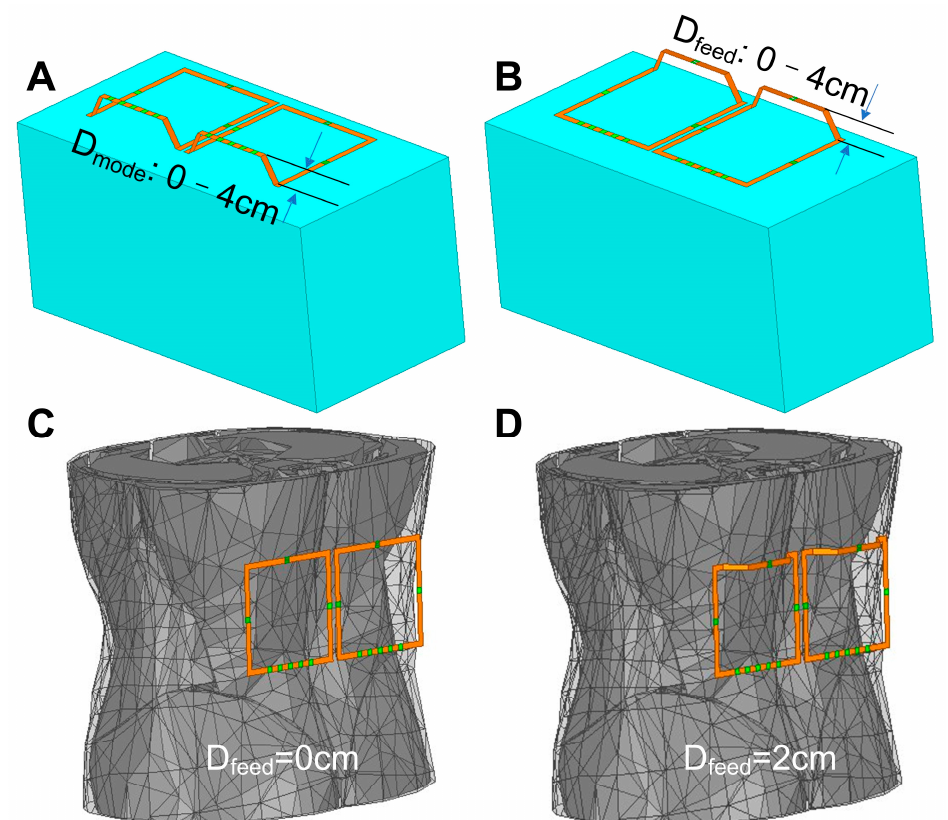
Figure 2. EM simulation models for optimizing lift-off distances of the mode conductor D mode ( A ) and the feed conductor D feed ( B ). Simulation models of the original ( C ) and optimized ( D ) self-decoupled coil on the human spine.